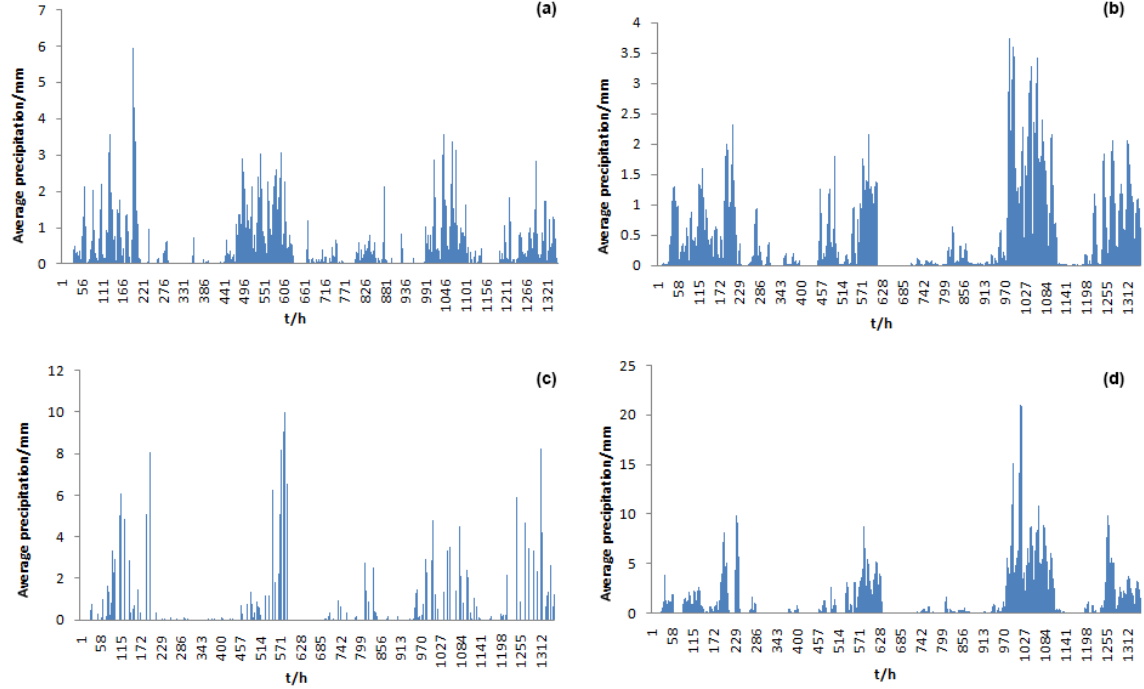
Figure 3. Precipitation pattern comparison of two precipitation products (2012). (a) is the average precipitation of rain gauges, (b) is the average precipitation of WRF with 24h lead time, (c) is the average precipitation of WRF with 48h lead time, and (d) is the average precipitation of WRF with 72h lead time.